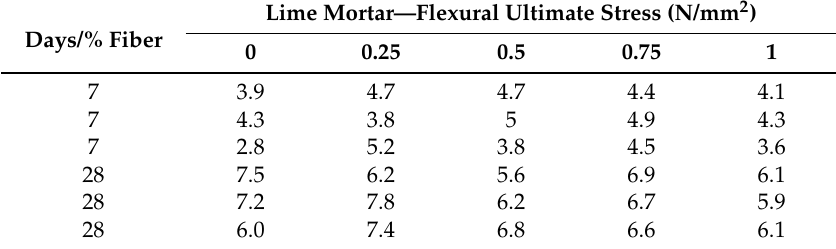
Table 4. Flexural tests for lime mortar.